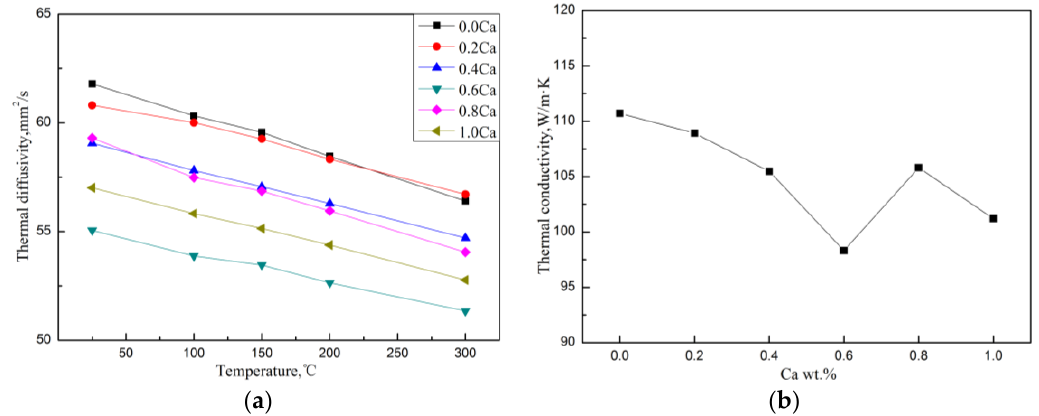
Figure 9. Thermal diffusion ( a ) and room temperature thermal conductivity ( b ) of Mg–4Si–yCa alloy. Table 4. Volume fraction of second phase of Mg–4Si–yCa alloy. Ca Content (wt.%)